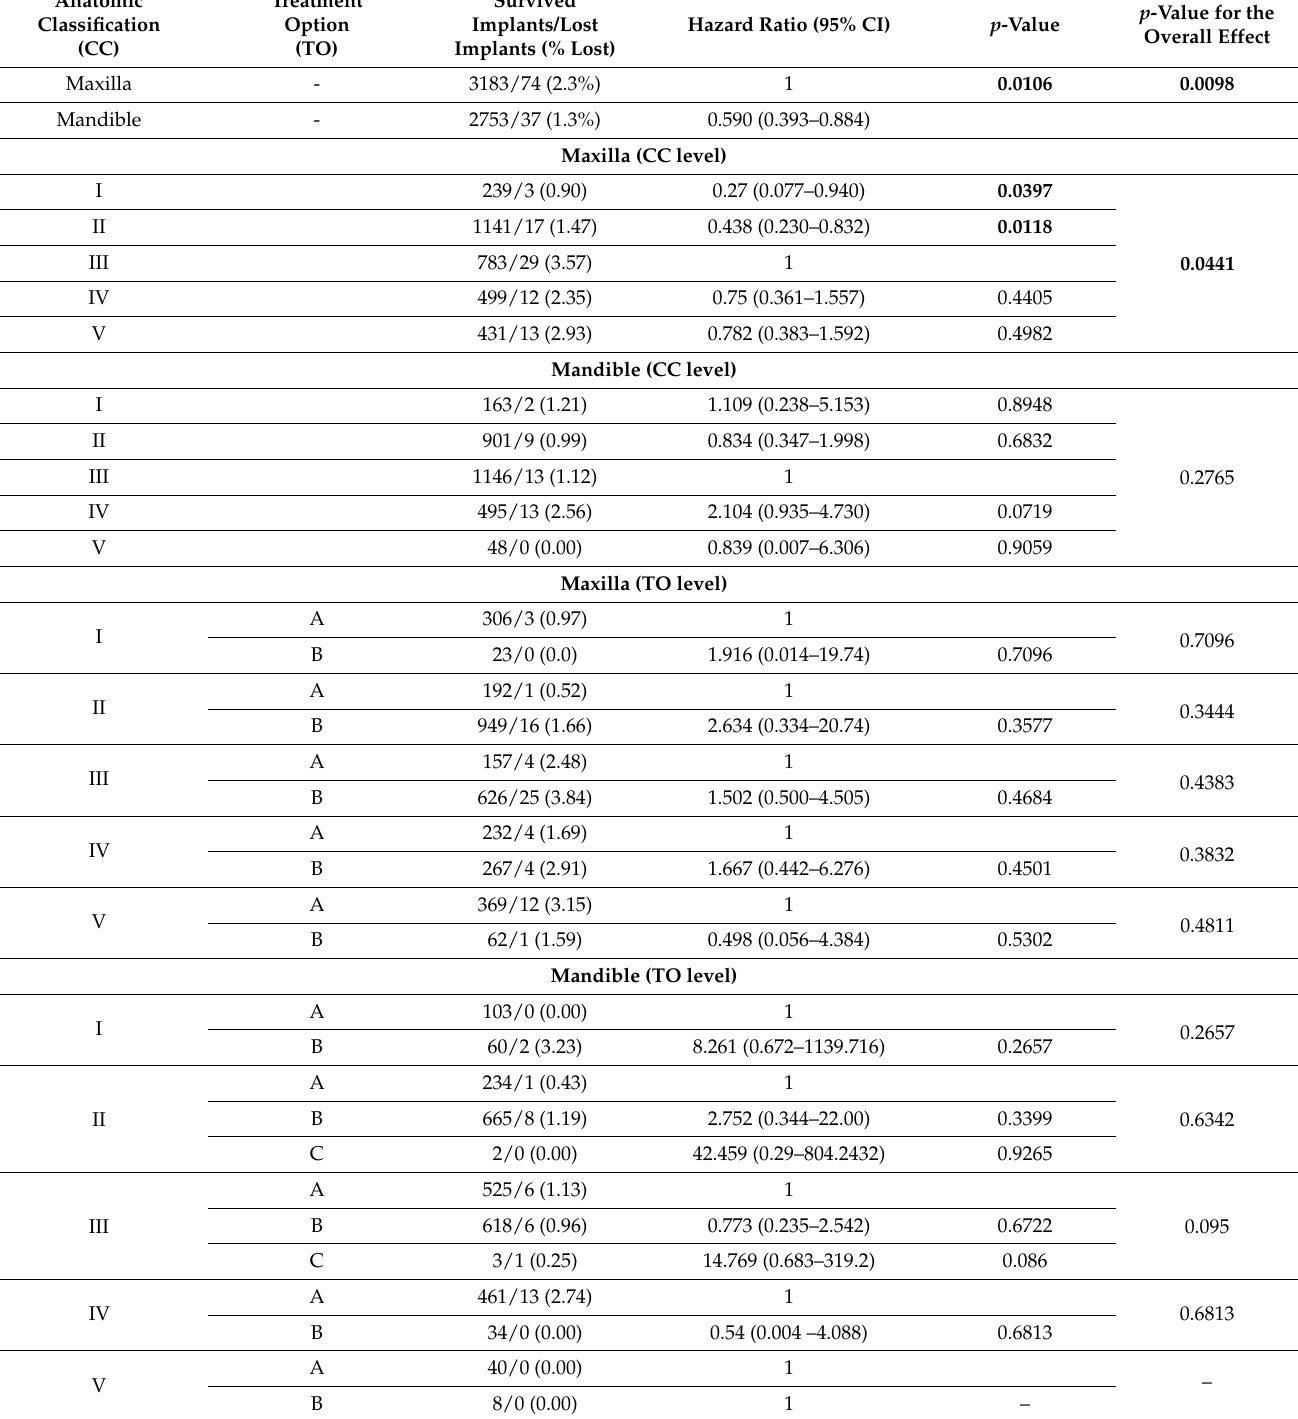
Table 6. Calculated risk ratios for the implant loss outcome per anatomic classification (maxillary CCs I–V and mandibular CCs I–V) and individual TOs per CC. The values were calculated from the Cox regression analysis using the effect of the patient as a random effect. The Firth correction was used when levels had zero events. p -values indicating statistical significance are marked in